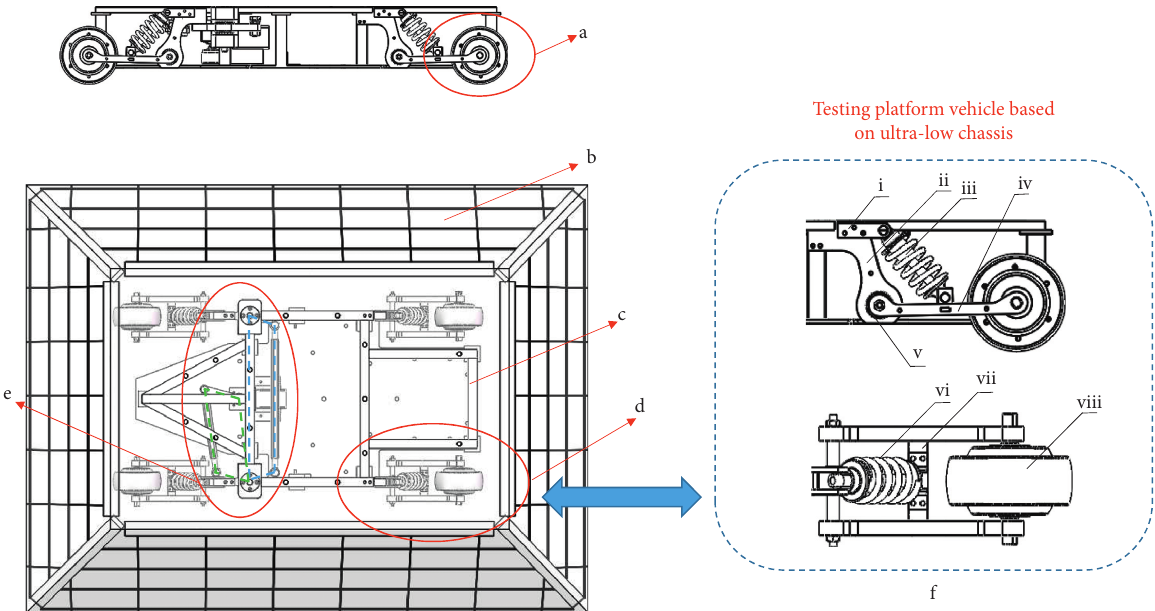
Figure 3: Structure of testing platform vehicle: (a) power system; (b) bodyshell; (c) loadable frame; (d) suspension system; (e) steering system; and (f) suspension system detailed display diagram with (i) mounting lugs, (ii) load-bearing arm, (iii) shock absorber, (iv) rocker, (v) double-row angular contact ball bearings, (vi) spring, (vii) supporting crossarm, and (viii)